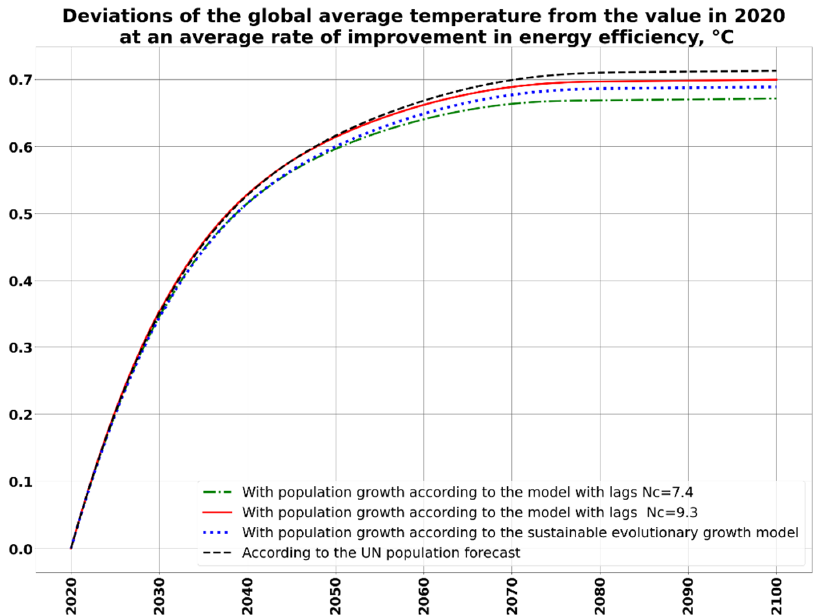
Figure 25. Dynamics of the deviation of the average global temperature of the surface atmosphere in the 21st century in the implementation of the ambitious scenario of the Great Energy Transition, as well as the application of CCS technologies in coal energy.